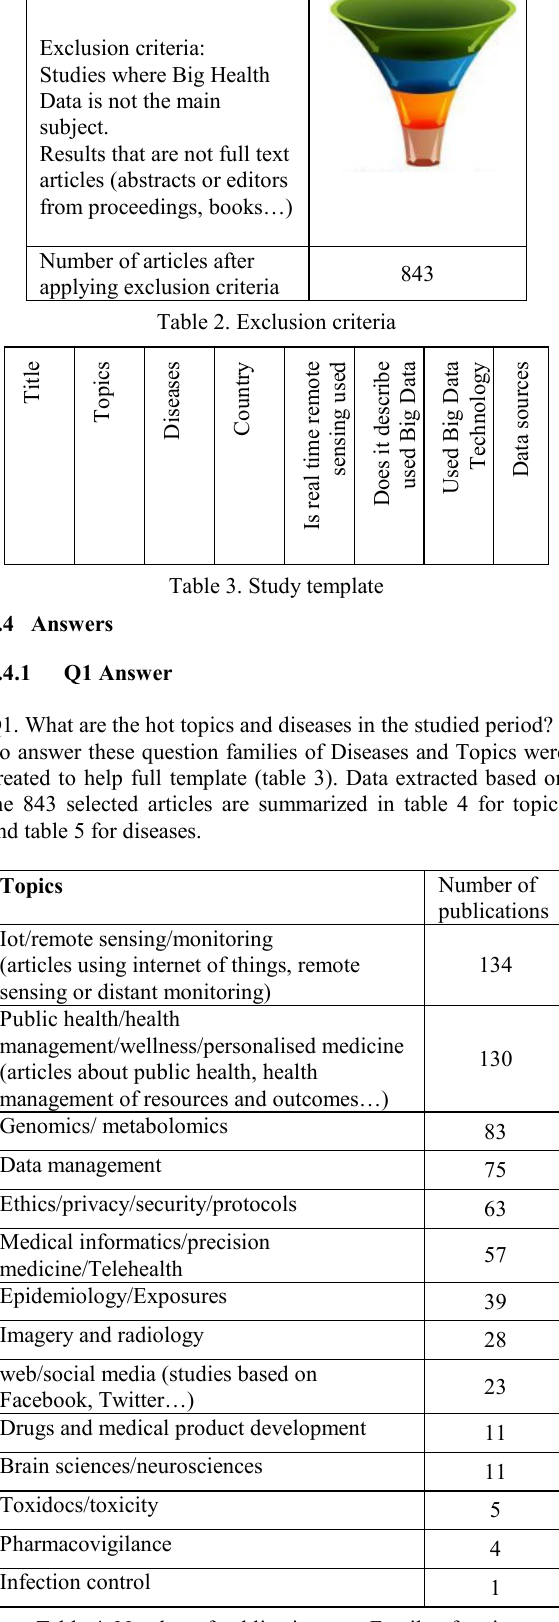
Table 4. Number of publications per Family of topics